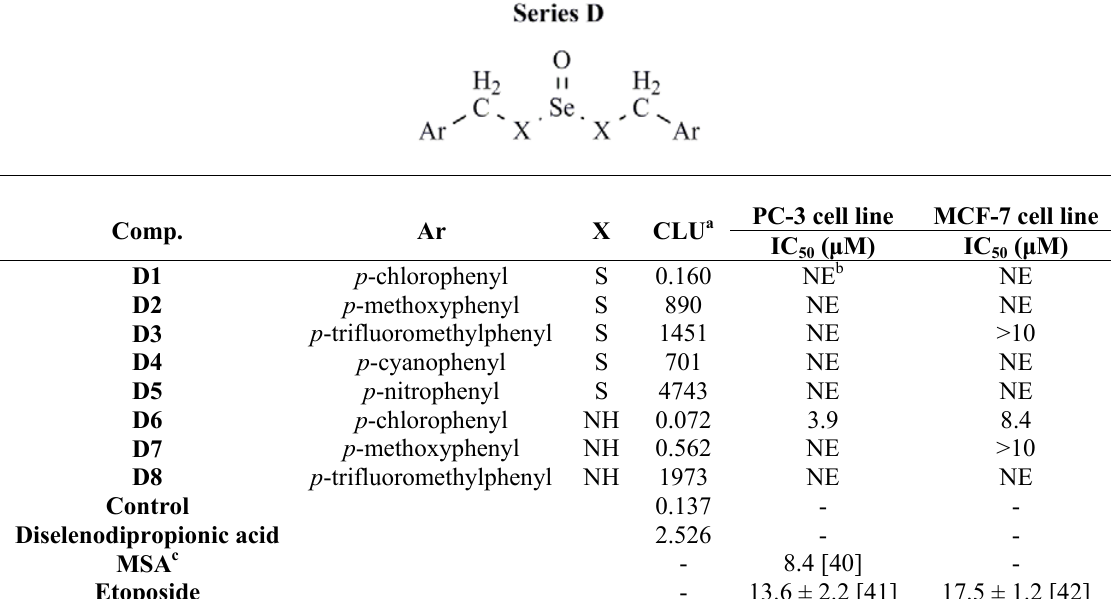
) of the compounds D1-D8 . 50